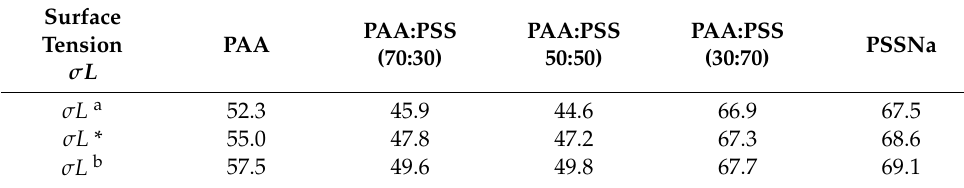
Table 2. Data used for determination of surface tension of the DMEM liquid